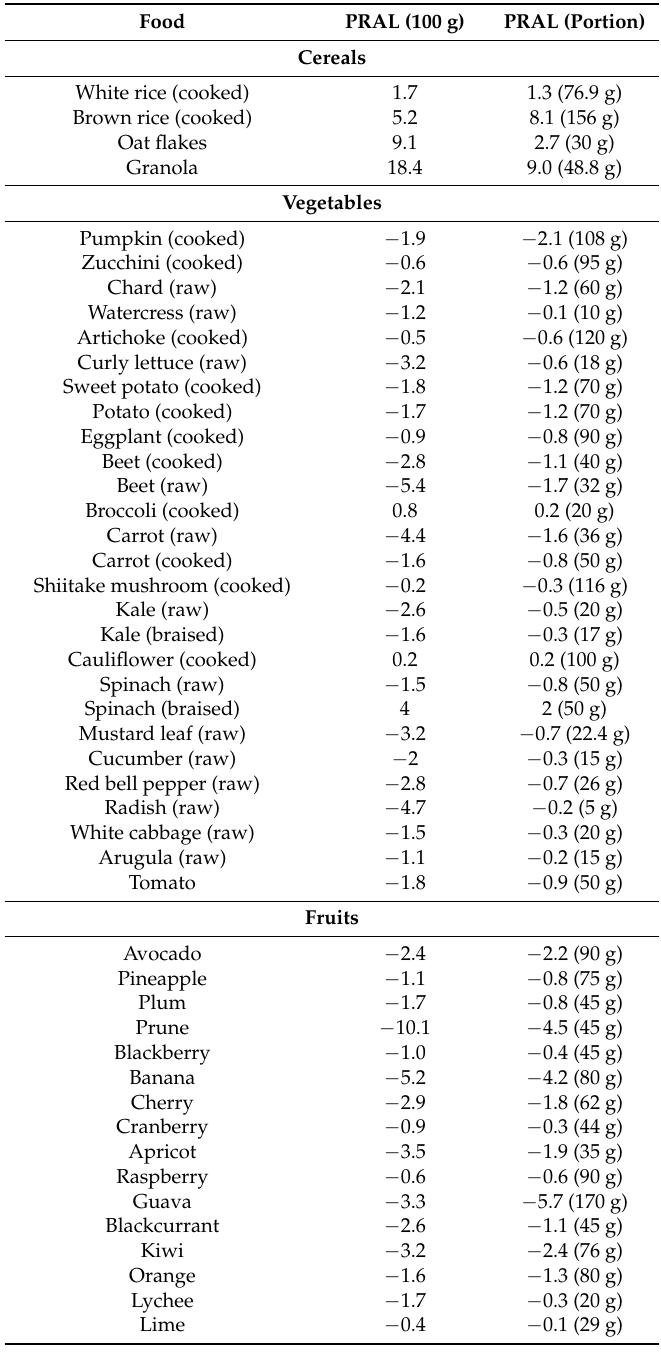
Table 2. Renal acid load potential of